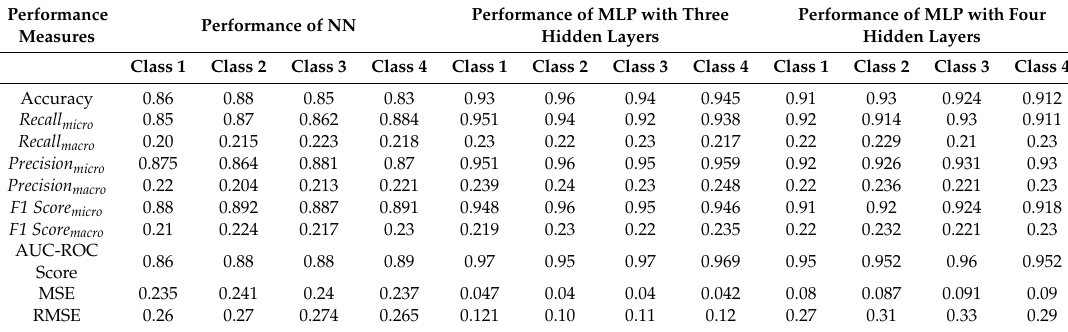
Table 1. Performance of Neural Networks (NN) and MultiLayer Perceptron (MLP) with N h = 30 for each class averaged over ten independent runs. Performance Performance of MLP with Three Performance of MLP with Four Performance of NN Measures Hidden Layers Hidden